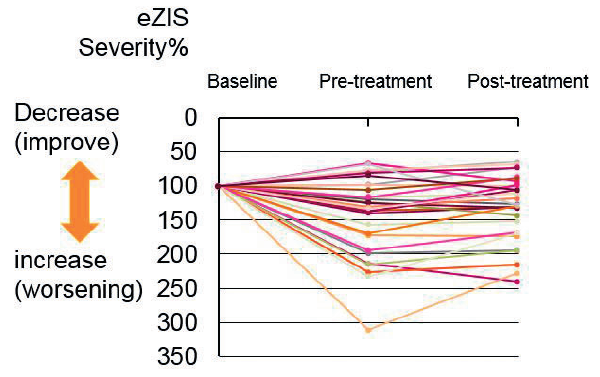
Figure 2. The eZIS sensitivity % changes for three SPECT examinations.